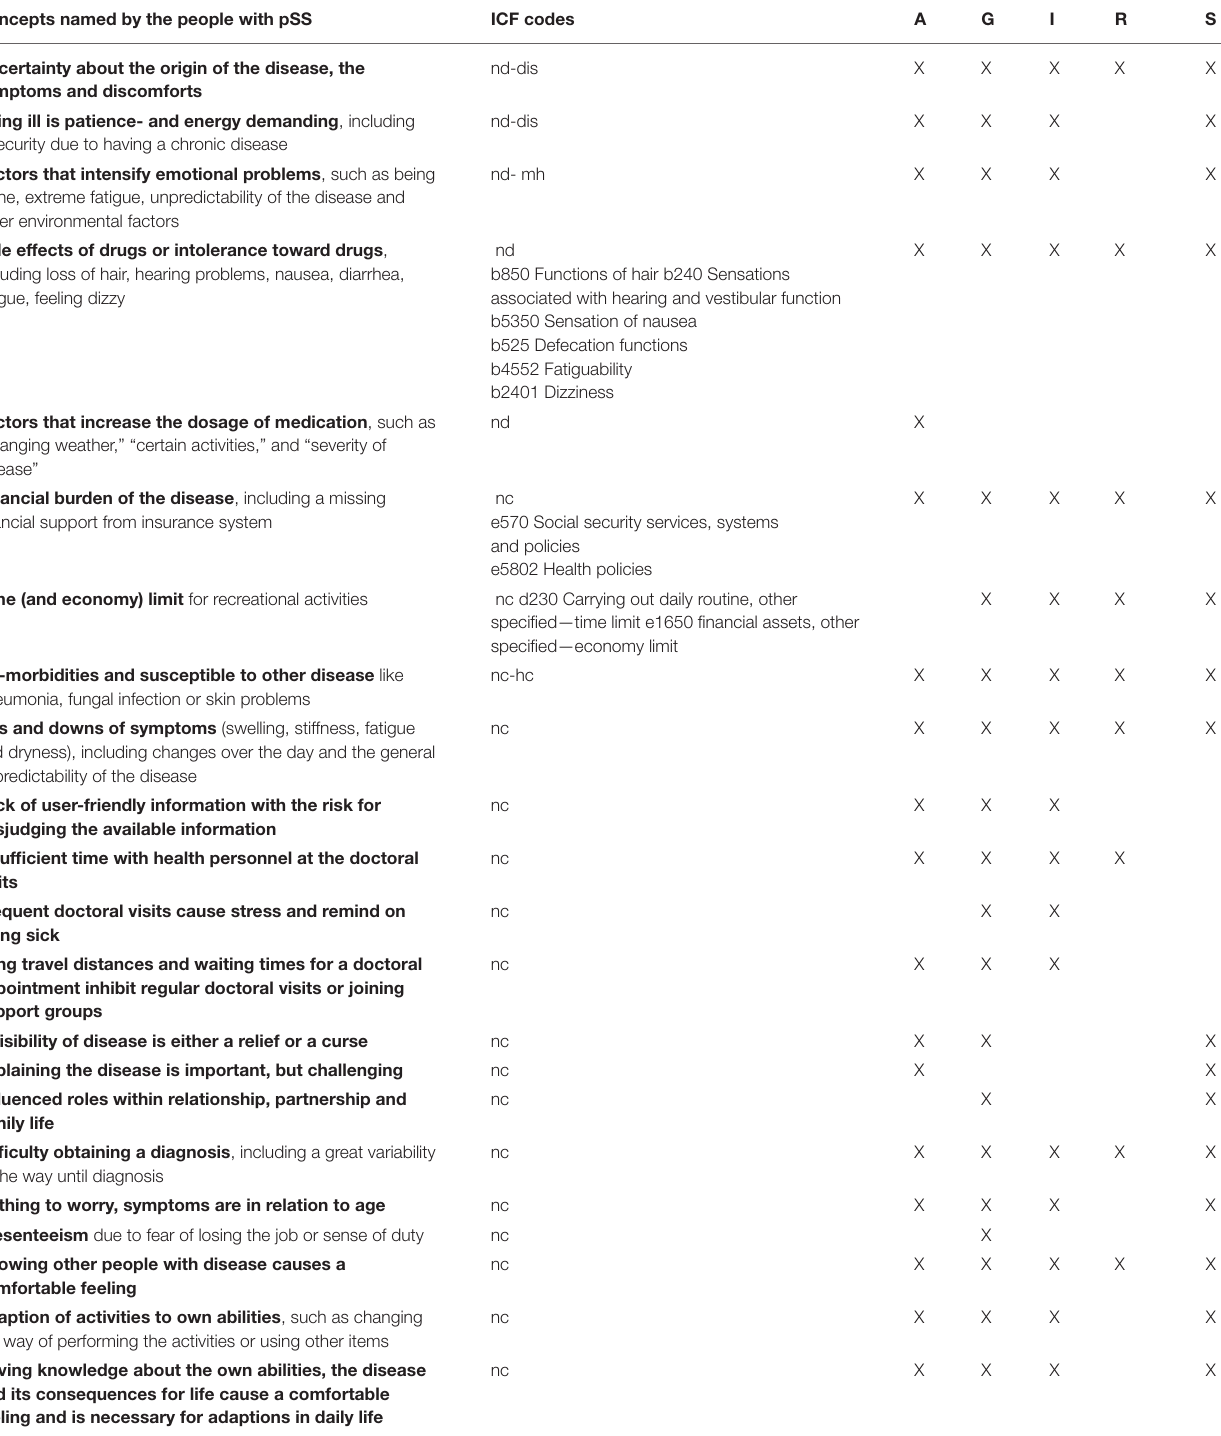
TABLE 3 | Not covered, not